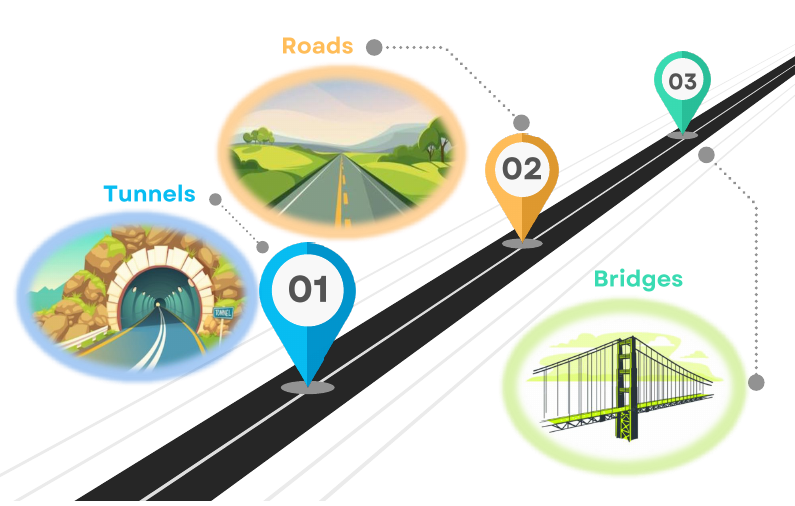
Figure 1. Use cases covered by our